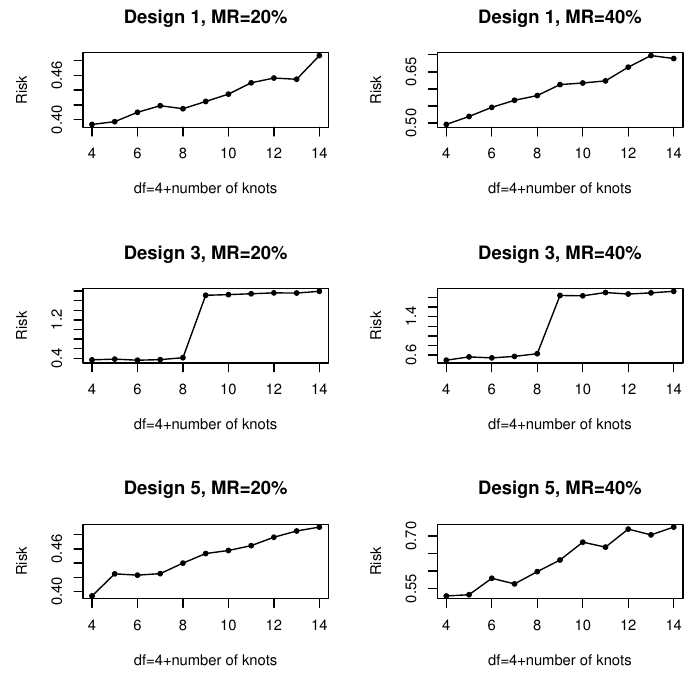
Figure 2. The curves of the risk with the number of knots over 1000